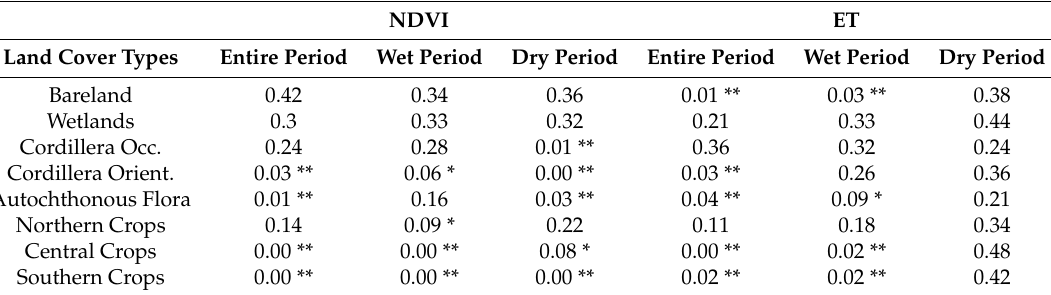
Table 3. Result of the Mann-Kendall (MK) test for the land cover type trend